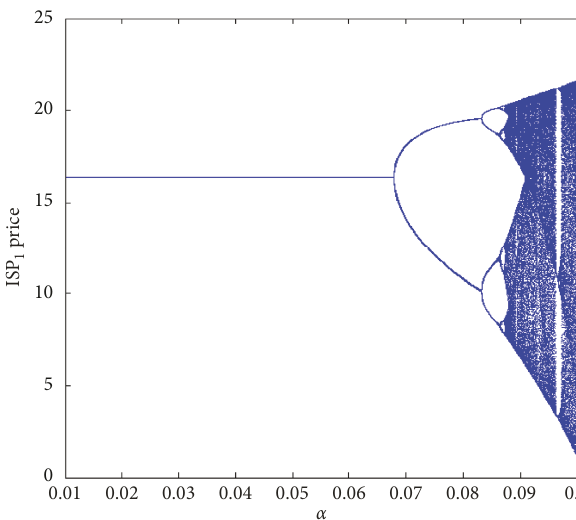
Figure 2: Bifurcation diagrams of p